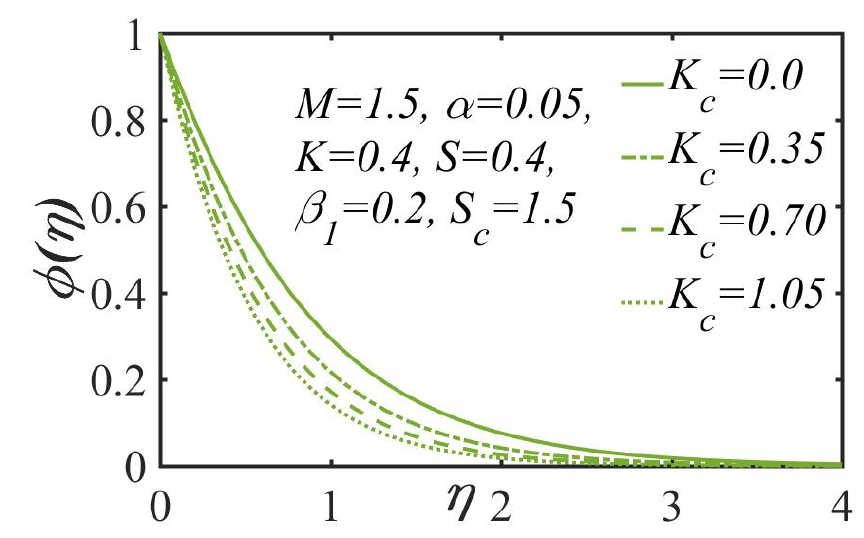
Figure 13. Concentration magnitude for K c ≥ 0.